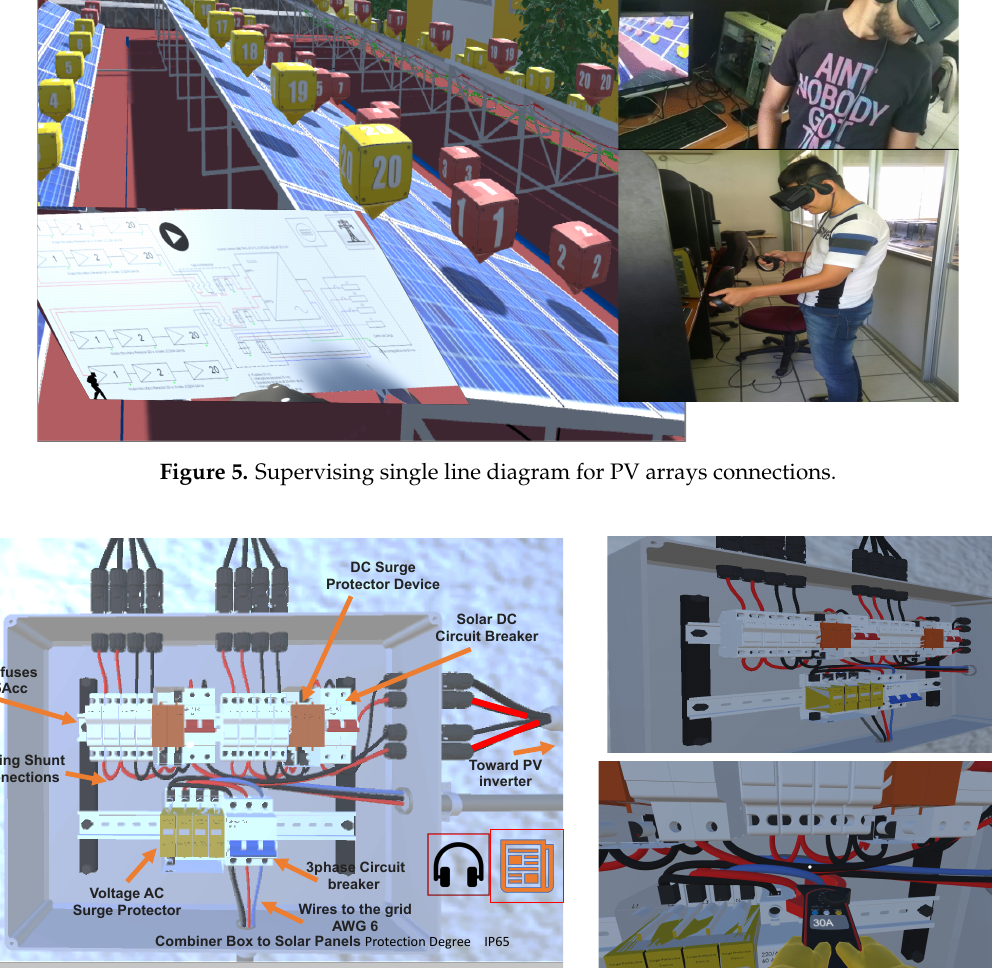
Figure 6. Combiner box